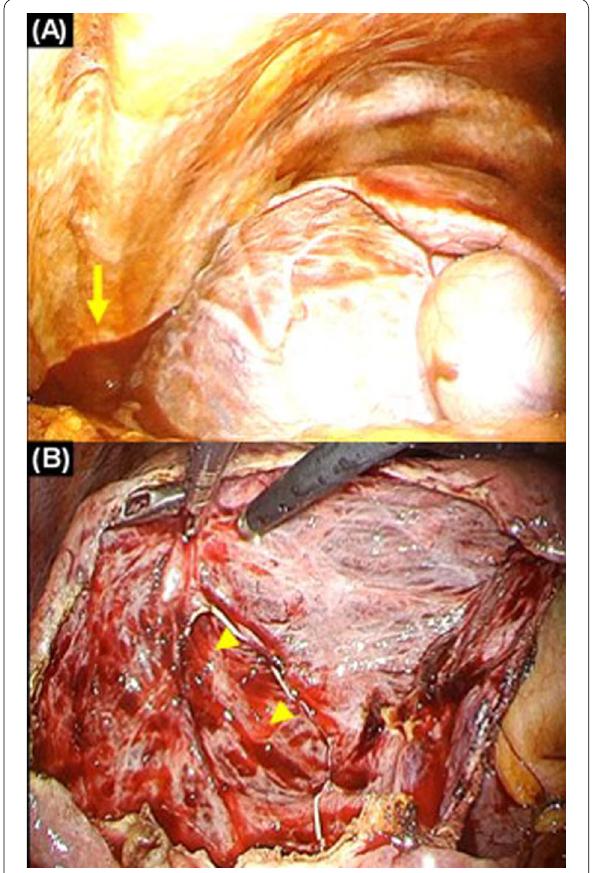
Fig. 2 Intraoperative findings of case 1. A Surgical exploration revealed hemoperitoneum (arrow) and a voluminous hepatic cyst, occupying the right lobe. B Continuous oozing was found at the posterior wall of the cyst (arrow heads)